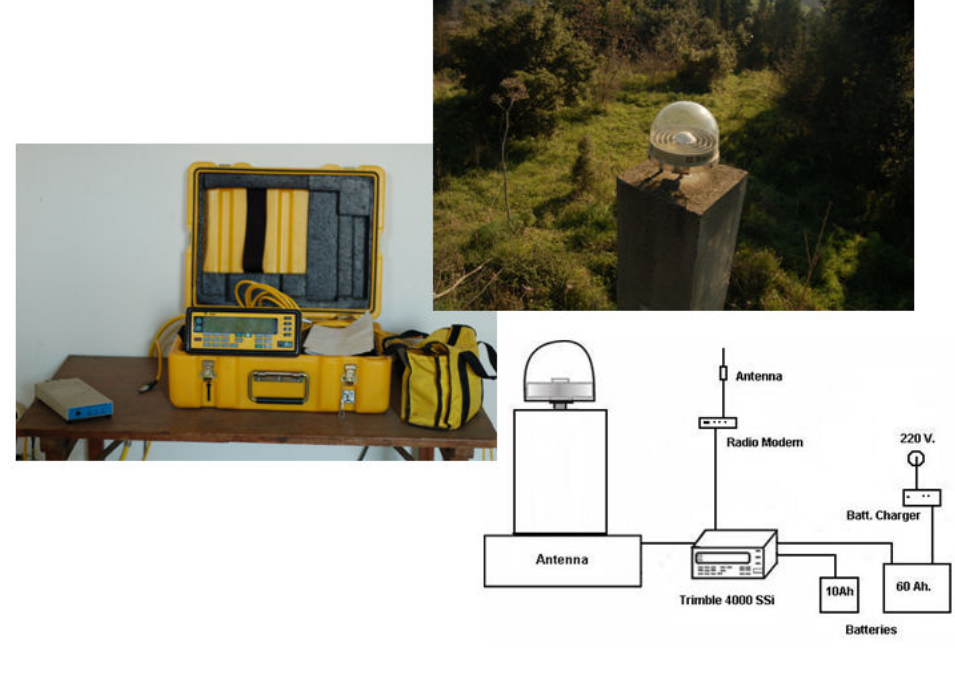
Figure 2. GPS sensor named KANT functioning 24 hours/day (Trimble 4000 SSE with a choke-ring model antenna).